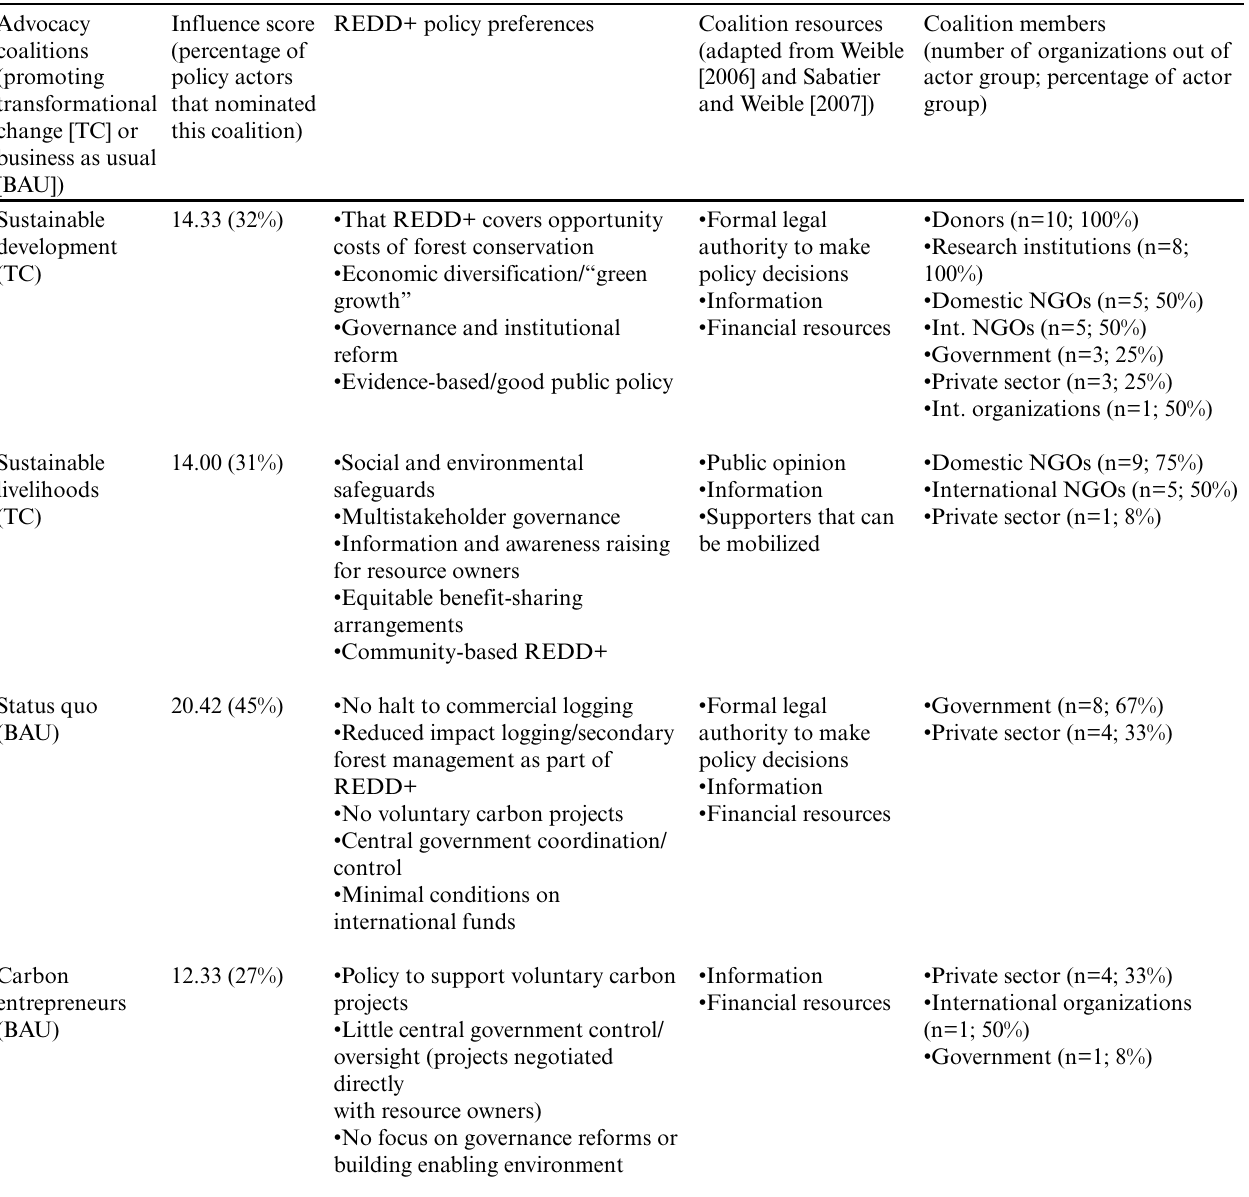
Table 2 . Advocacy coalitions in the REDD+ policy domain in Papua New